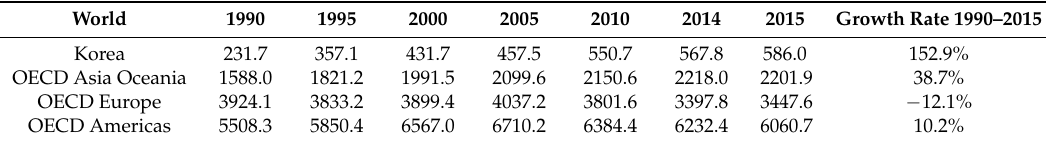
Table 4. CO 2 emissions around the world/million tons of CO 2 .